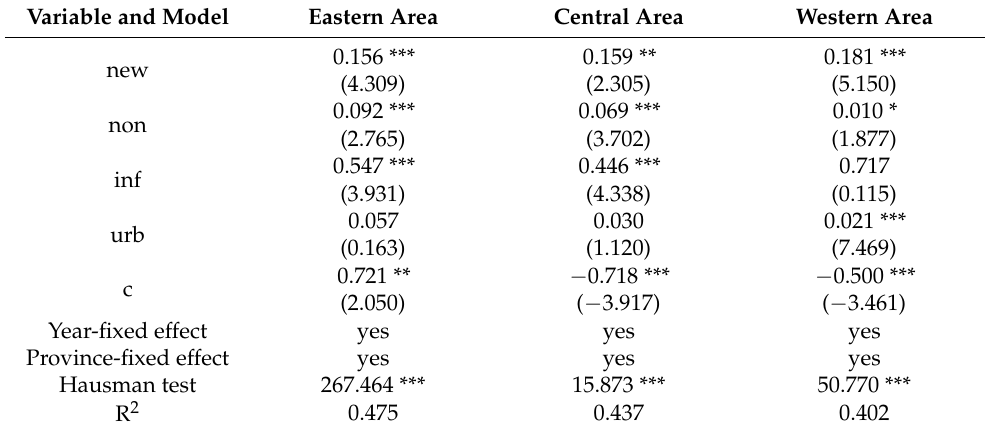
Table 6. Results of heterogeneity